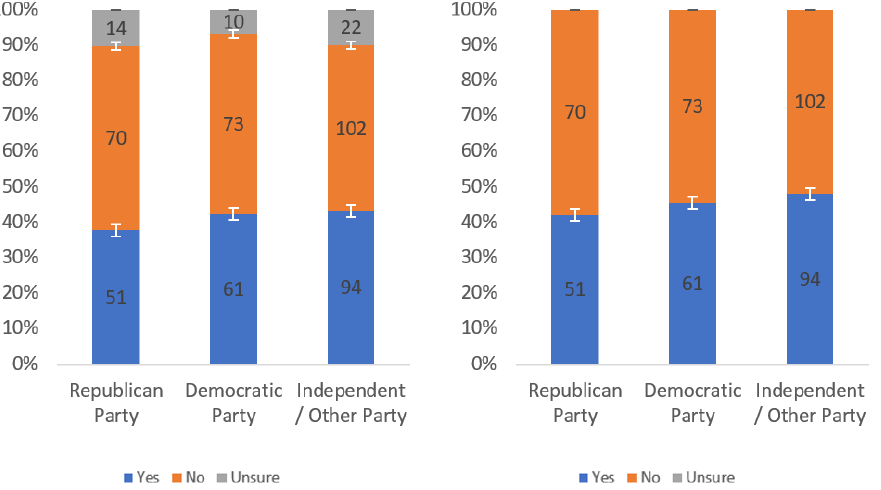
Figure 43. Responses regarding label annoyingness by party affiliation including ( left ) and excluding ( right ) unsure responses.